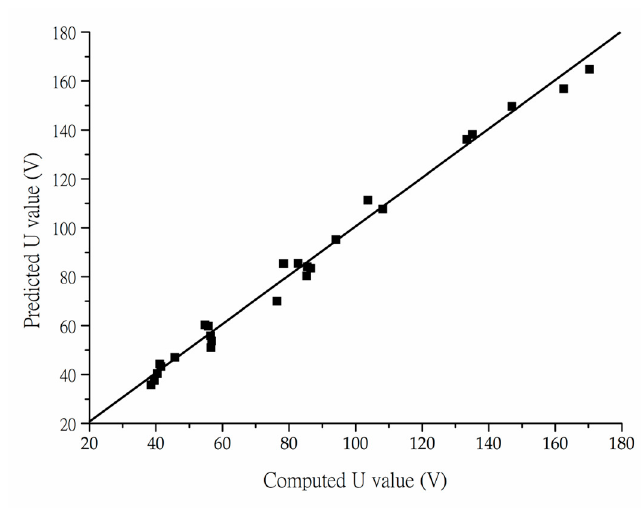
Figure 8. The goodness-of-fit plot for the fitting equation.